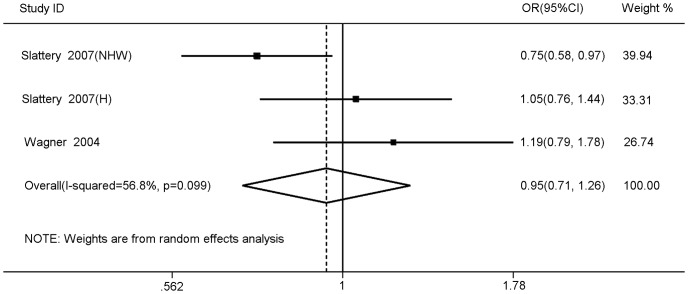
Forest plots for meta-analysis of the association between IRS2 rs1805097 polymorphism and breast cancer risk under homozygote model (A/A vs. G/G).